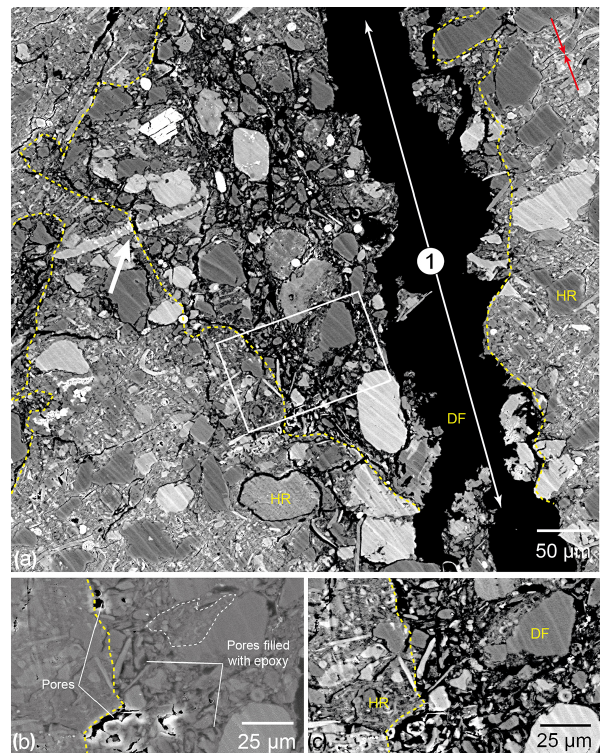
Figure 11. Detailed microstructures at ROI-2 in sample COX- 10MPa. (a–c) The damaged fabric (DF) within the main synthetic fracture (indicated by number 1) is made of fragments of non-clay minerals and clay matrix derived from the host rock (HR). (a) Some grains within the damaged fabric, but close to the boundary between the damaged fabric and the host rock, show transgranular fractur- ing (white arrow). The white box refers to Fig. 11a and b. Detailed observations in (b) and c (SE2 SEM and BSE–SEM micrographs of the same sub-area, respectively) show that parts of the damaged fabric display (i) porous island, where pores are between the frag- ments of non-clay and clay matrix, whereas other parts display (2) low porous islands made of fragments of non-clay minerals em- bedded in a dense, tight clay matrix (within the region bounded by the dashed white line). Pores within the porous island can either be filled with epoxy (in deep black pixel values) or not. The orientation of the principal stress ( σ 1 ) is indicated by red arrows. The bedding is perpendicular to σ 1 . The dashed yellow lines indicate the bound- aries between the damaged fabric and the host